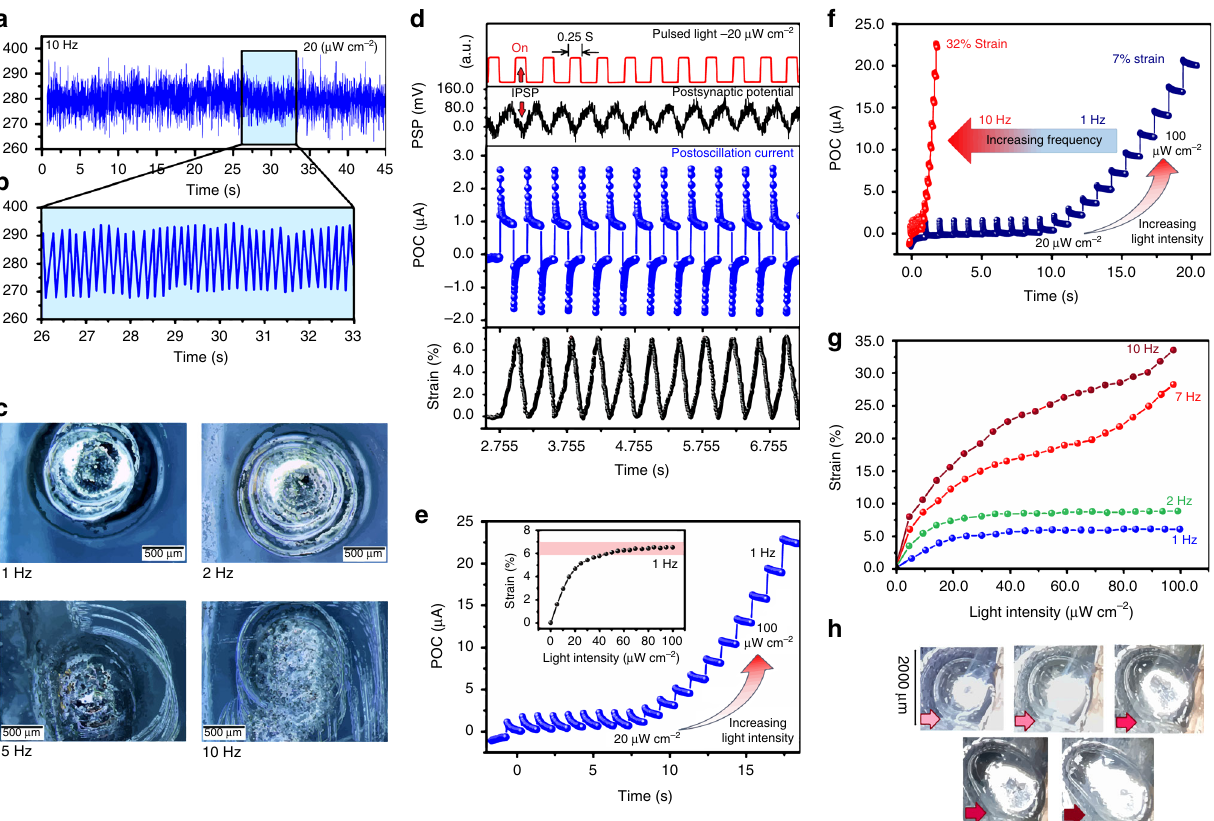
Fig. 5 The modulation of oscillation of the galinstan droplet. The a and b are the typical transitional motion of a 1280 μ m diameter galinstan droplet by applying sequential PSP pulses originated from the optical synapse. c The typical optical images show the oscillation of galinstan droplets with various frequencies. d From top to down, the graph of patterned pulsed light, variation of PSP and POC and its corresponding mechanical strain. A 20 μ W cm − 2 pulsed laser (530nm) with 2 Hz frequency and 250 ms intervals are employed. e The variation of POC and corresponding strain of liquid metal actuator when the light power is increasing from 20 to 100 μ W cm − 2 at constant frequency of 1 Hz. f The variation of POC of liquid metal droplet, when the combination of increased light intensity (from 20 to 100 μ W cm − 2 ) and increased pulse frequency caused unrested strain in galinstan droplet. g The effect of light intensity and frequency on mechanical strain of galinstan droplet. h Optical images demonstrate the sequential size expansion of galinstan droplet (strain is sequentially increasing from left to